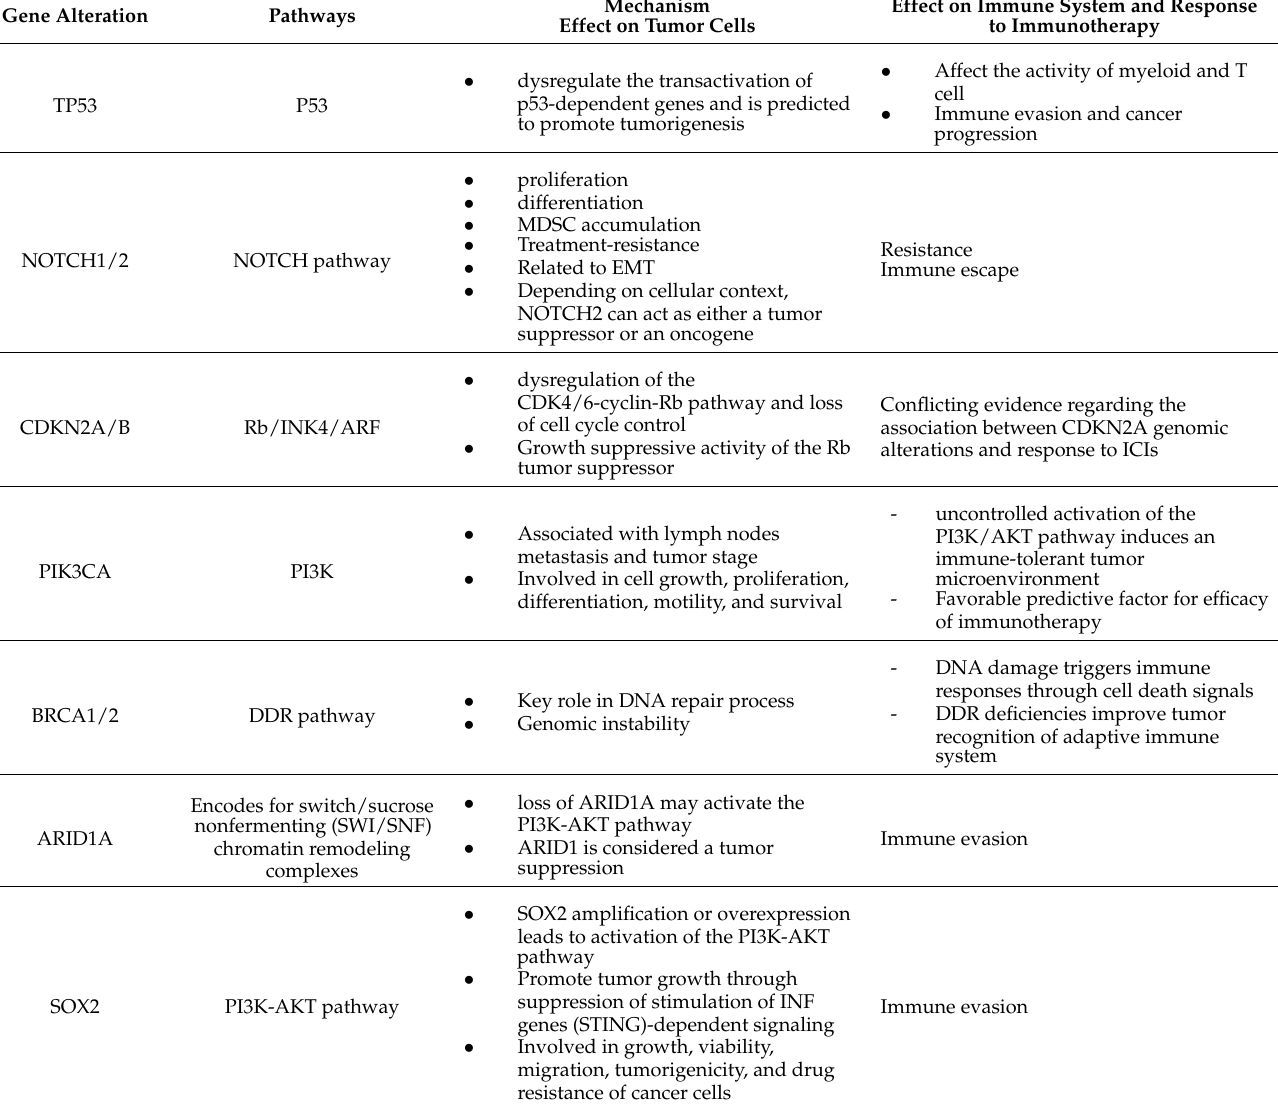
Table 5. Effects of pathways dysregulation in head and neck squamous cell